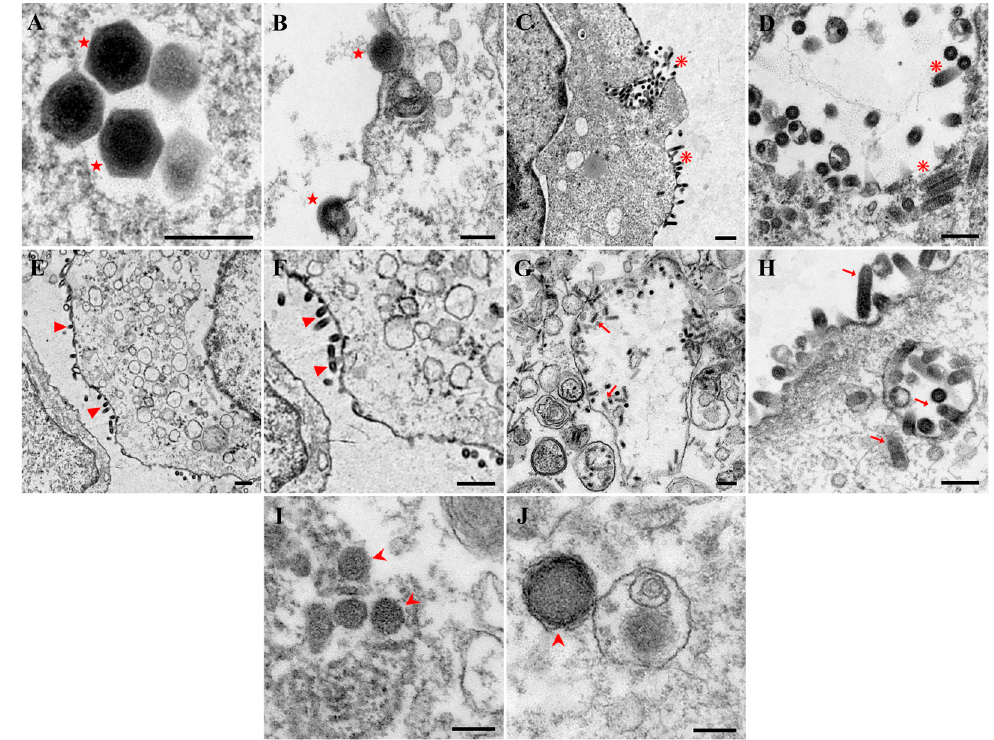
Figure 8. Ultrastructural observations of BIV, VHSV, HIRRV, IHNV, or LCDV-infected JFSP cells. Abundant virus particles were observed in BIV, VHSV, HIRRV, IHNV, or LCDV-infected cells. ( A , B ) Virus particles of BIV-infected cells. Scale bar = 200 μ m. ( C , D ) Virus particles of VHSV-infected cells. ( C ) Scale bar = 500 μ m. ( D ) Scale bar = 200 μ m. ( E , F ) Virus particles of HIRRV-infected cells. Scale bar = 500 μ m. ( G , H ) Virus particles of IHNV-infected cells. Scale bar = 200 μ m. ( I , J ) Virus particles of LCDV-infected cells. Scale bar = 200 μ m. ★ : BIV, ❋ : VHSV, ▶ : HIRRV, ➞ : IHNV, ➤ : LCDV.